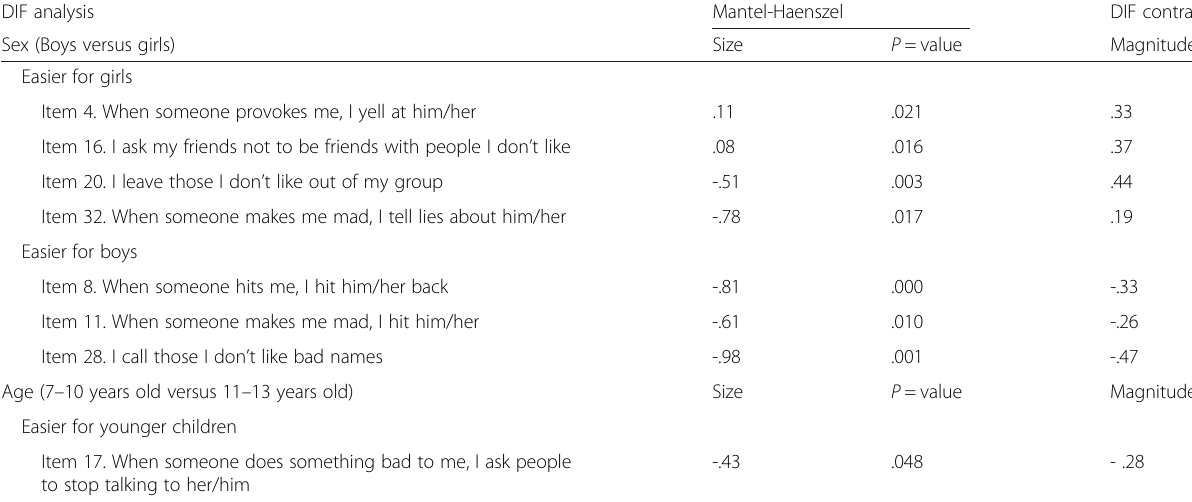
Table 2 Differential item functioning of the PAB-S DIF